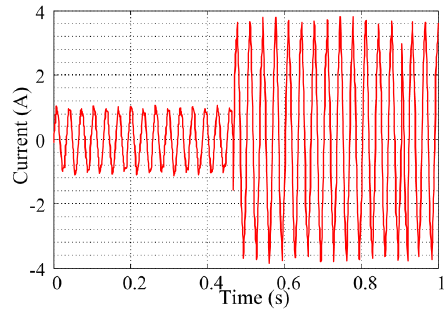
Figure 25. Current in phase A at 𝒏 𝑨𝒔/𝒄 = 8%.